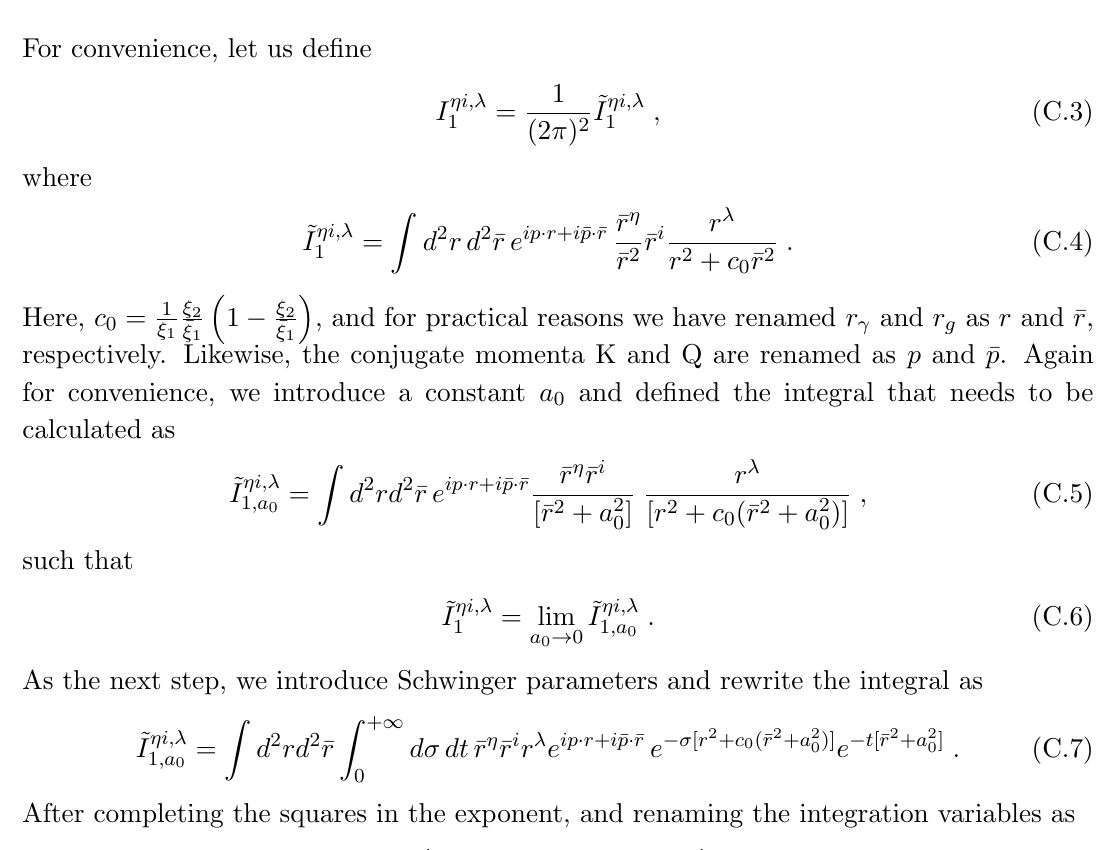
Figure 4 . The ‘Mercedes’ type con(cid:12)guration of the outgoing particles in the transverse plane for the process q q(cid:13)g !